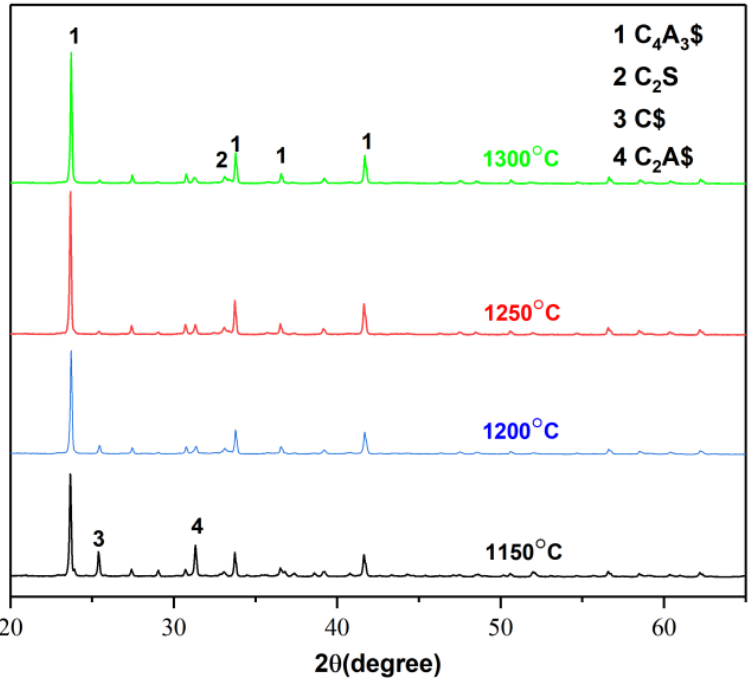
Figure 8. XRD patterns of S2 samples fired at different temperatures.